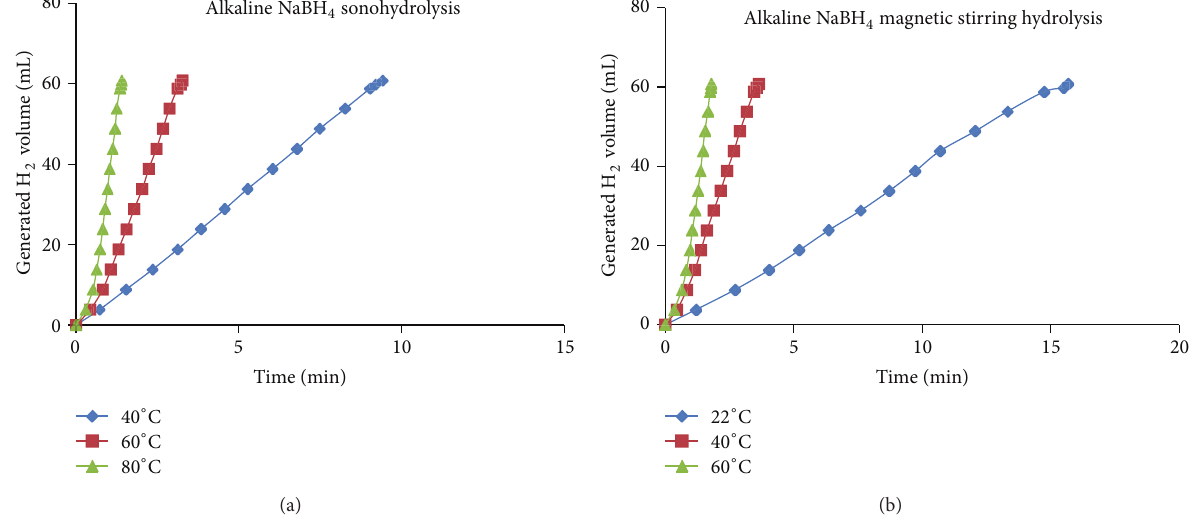
Figure 5: Hydrogen generation volume versus time for sonohydrolysis and magnetic stirring hydrolysis of alkaline (10wt.%) 0.12 NaBH 4 solutions in presence of 0.5 mg CoB-1